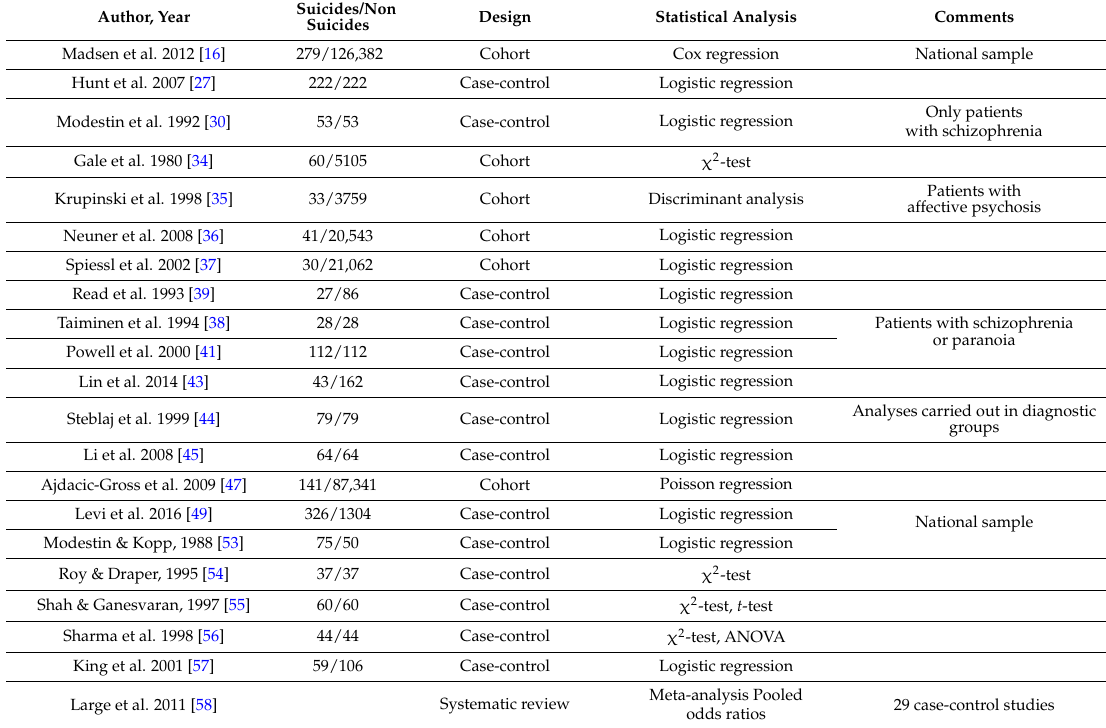
Table 2. Studies examining predictors of suicide among psychiatric